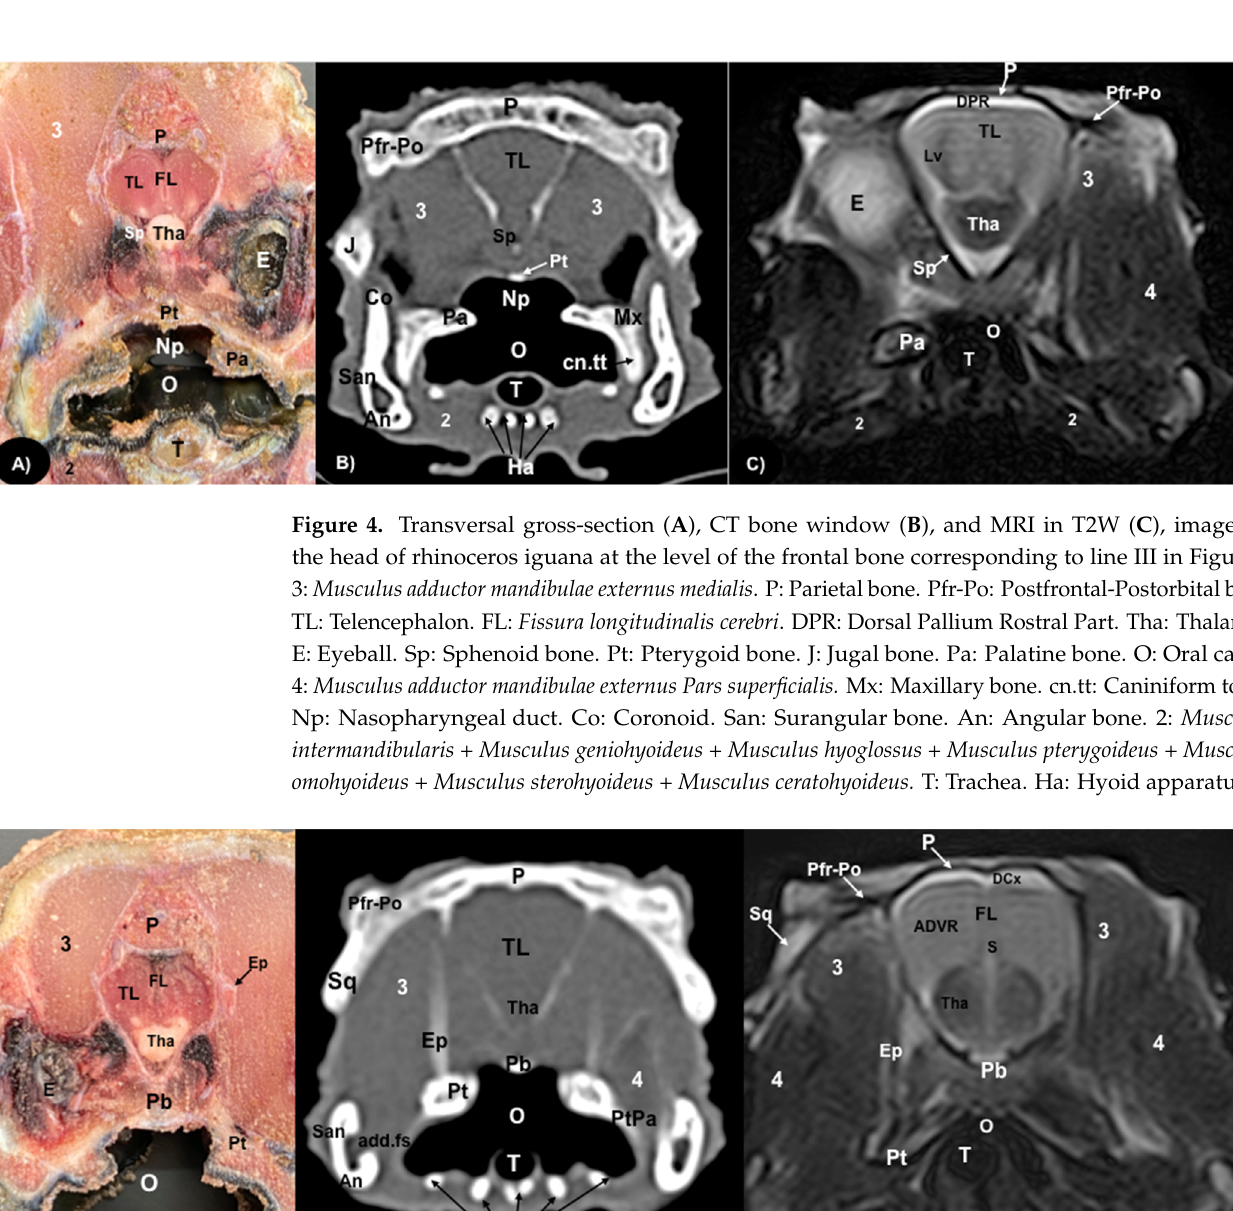
head of rhinoceros iguana in the orbital region corresponding to line II in Figure 1. Fr: Frontal bone.